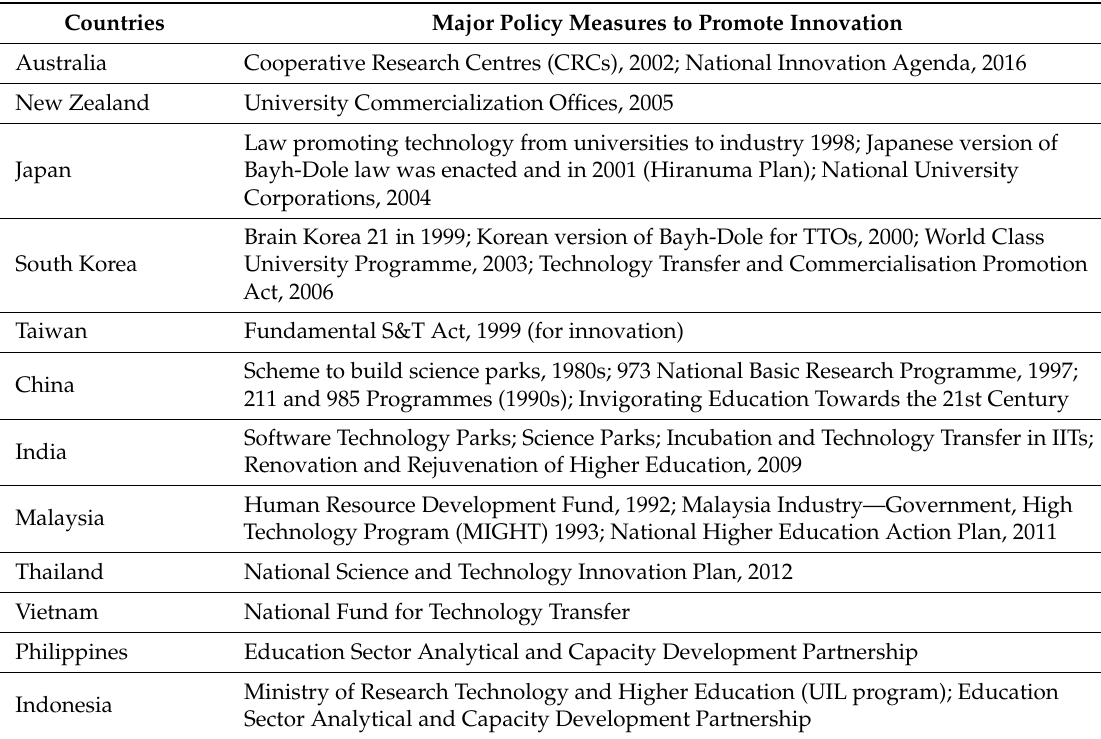
Table 4. Major policies promoting innovation in